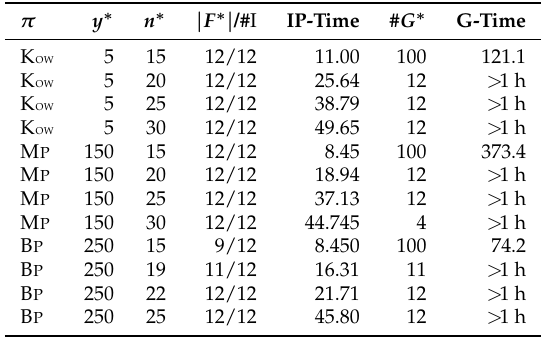
Table 5. Results of Steps 4 and 5 with d max = 3 and θ = 0.